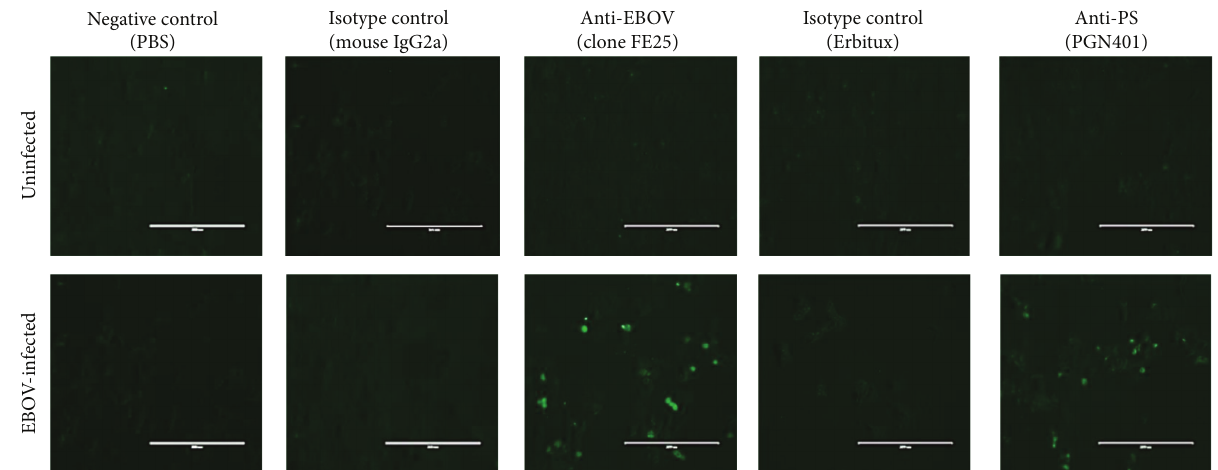
Figure 2: Immunofluorescence staining of uninfected and EBOV-infected cells after staining with antibodies against EBOV (clone FE25), PS (PGN401), and isotype antibodies. Scale bar indicates 200 nm.